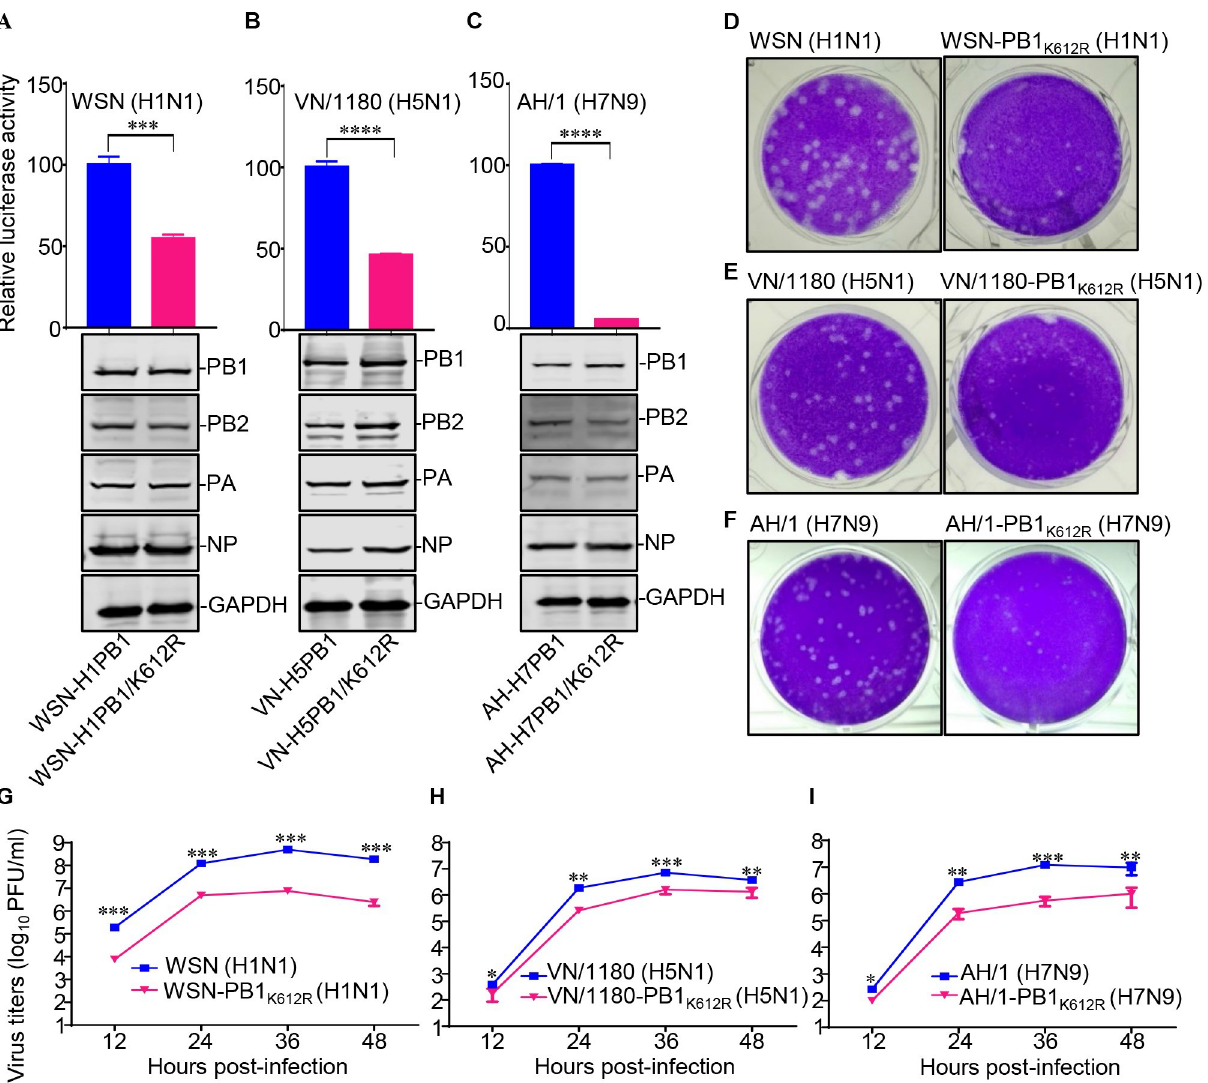
Fig 7. SUMOylation at K612 of IAV PB1 is essential for vRNP complex activity and virus replication in vitro. (A-C) Four vRNP protein expression plasmids (PB2, PA, NP, and PB1 or a PB1/K612R mutant) derived from WSN (H1N1) (A), VN/1180 (H5N1) (B), or AH/1 (H7N9) (C), together with a luciferase reporter, pHH21-SC09NS F-Luc, and an internal control reporter, pRL-TK, were cotransfected into HEK293T cells. Forty-eight hours later, the cell lysates were subjected to a dual-luciferase reporter assay. Western blotting was also performed to assess the expression of the transfected vRNP protein constructs (bottom panel). (D-F) Plaque phenotypes of WSN (H1N1) or WSN-PB1 K612R (H1N1) (D), VN/1180 (H5N1) or VN/1180-PB1 K612R (H5N1) (E), and AH/1 (H7N9) or AH/1-PB1 K612R (H7N9) (F) on MDCK cells. (G-I) Growth curves of WSN (H1N1) or WSN-PB1 K612R (H1N1) (G), VN/1180 (H5N1) or VN/1180-PB1 K612R (H5N1) (H), and AH/1 (H7N9) or AH/1-PB1 K612R (H7N9) (I). MDCK cells were inoculated with the indicated viruses at an MOI of 0.001, and the supernatants were collected at the indicated time points to determine the virus titers by use of plaque assays. Data shown are representative of three independent experiments. The results are expressed as the mean ± standard deviation (SD) of triplicates and the significance was tested with a Student’s t-test (A-C) or a one-way ANOVA followed by t-test (G-I). � , P < 0.05; �� , P < 0.01; ��� , P < 0.001; ���� , P <